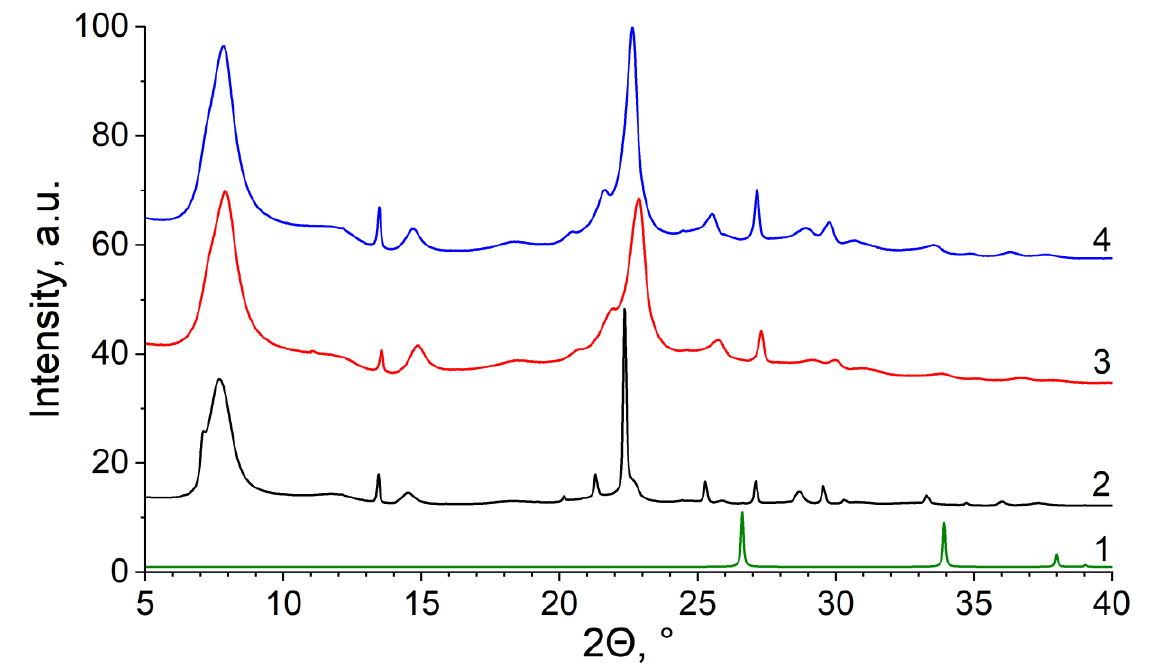
Figure 1. XRD patterns of SnO 2 (1), Sn-BEA (2), DeAl-BEA (3), and BEA (4); patterns are offset for clarity. 29 Si MAS NMR spectrum of Sn-BEA contains all peaks ( − 111.6, − 112.2, − 113.1, − 115.7